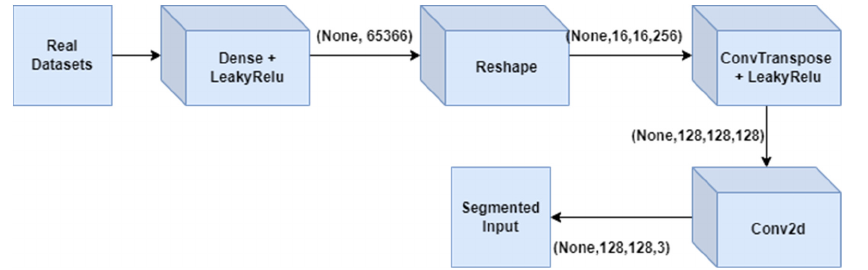
Figure 5. Architecture of generator GAN .